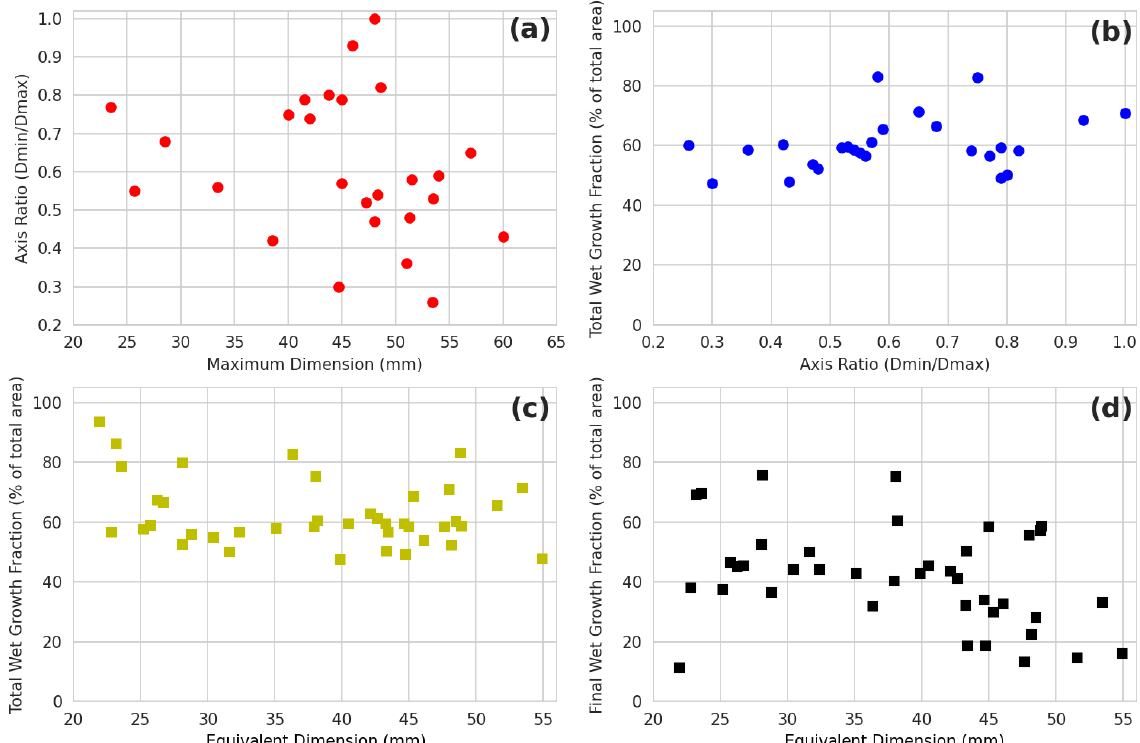
Figure 7. Hailstone properties derived from the LAT and manual measurements. Layer-analysis-technique-derived properties include the wet growth across the hailstone cross section as a fraction of the total area and the final wet-growth layer as a fraction of the total area. Equivalent dimension was calculated from an oblate spheroid model using the maximum and intermediate dimensions. Note that the minimum dimension used to calculate axis ratio was not measured for all hailstones, and therefore panels (a) and (b) have a reduced sample size of 26 compared to the complete collection of 40 hailstones used in panels (c) and (d) .